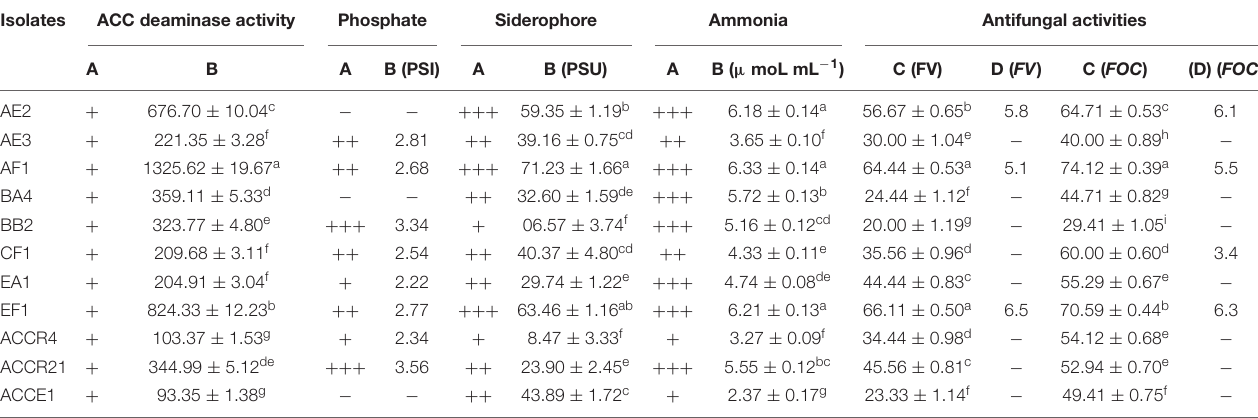
TABLE 2 | In vitro screening for assessing the endophytic plant growth-promoting, 1-Aminocyclopropane-1-carboxylate deaminase activity and antifungal activities for selected bacterial isolates obtained from sugarcane root. Isolates